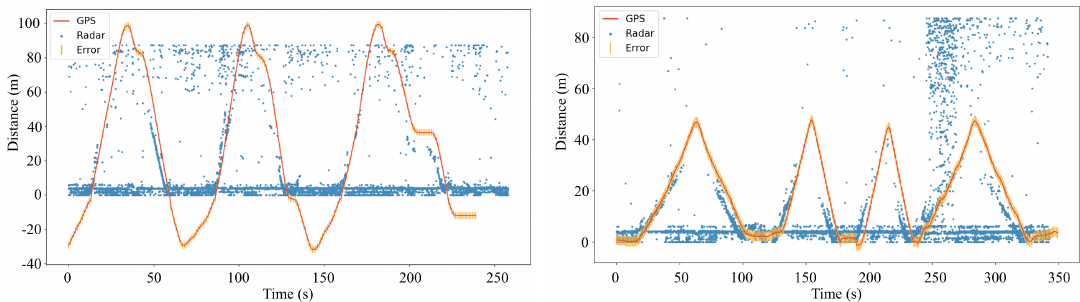
Figure 15. Plots of the movement of the car ( left ) and person ( right ) detected by the radar and also tracked by the GPS at the parking lot.